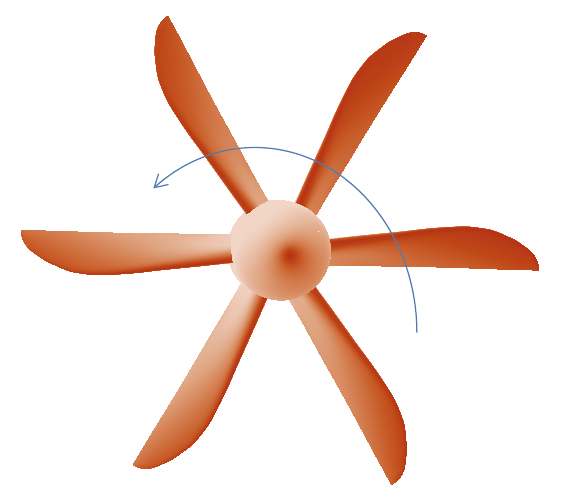
Figure 17: The counterclockwise rotation of the propeller.